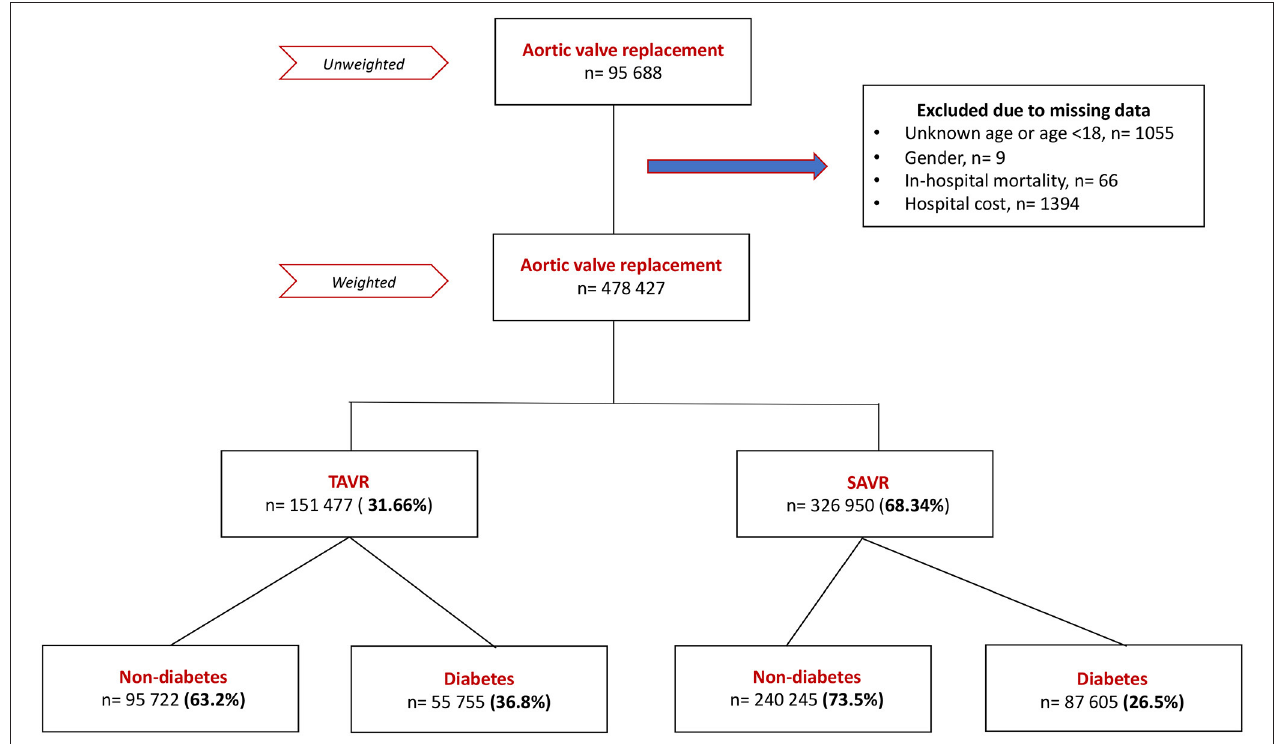
FIGURE 1 | Flow chart of the